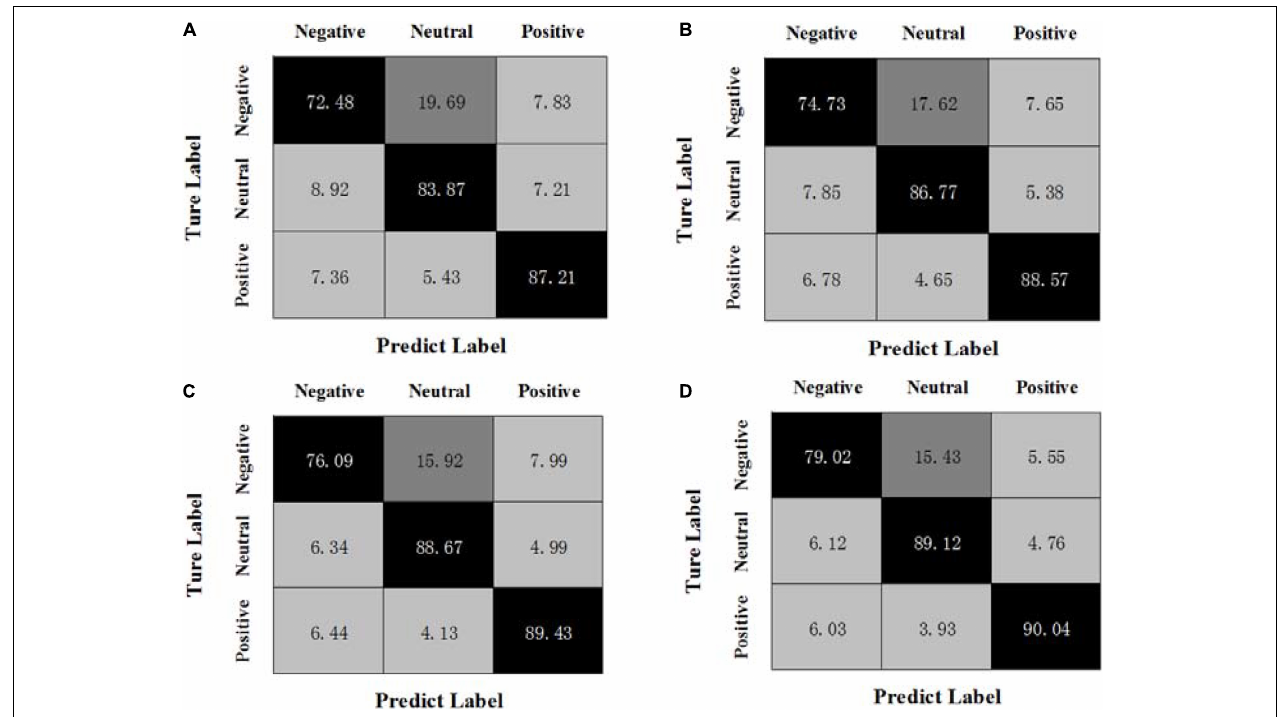
FIGURE 1 | Confusion matrices of MBCC on the SEED dataset, (A) β + γ , (B) α + β + γ , (C) θ + α + β + γ , (D) δ + θ + α + β + γ .